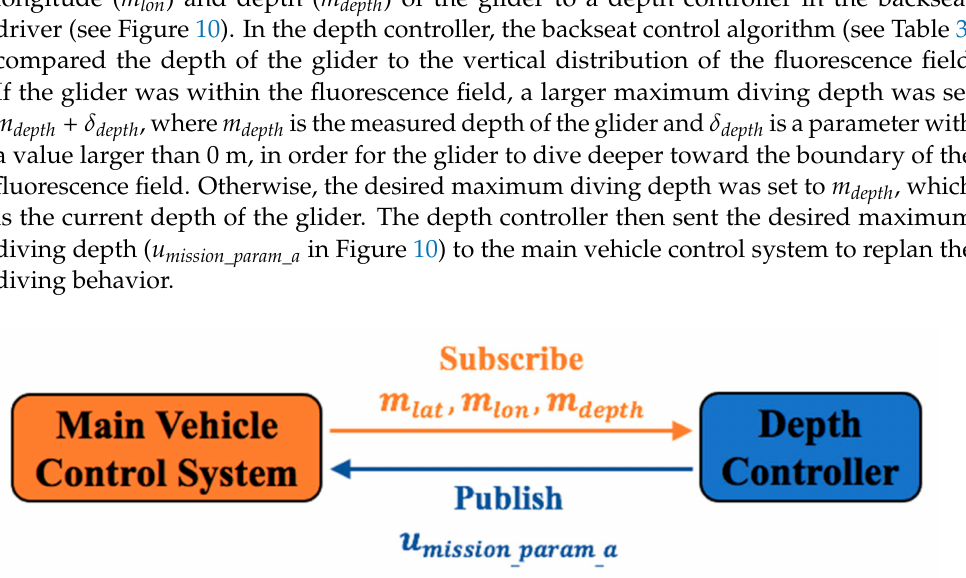
Figure 10. Exchange of data between the main vehicle control system and a depth controller when the glider changed its depth based on a simplified fluorescence